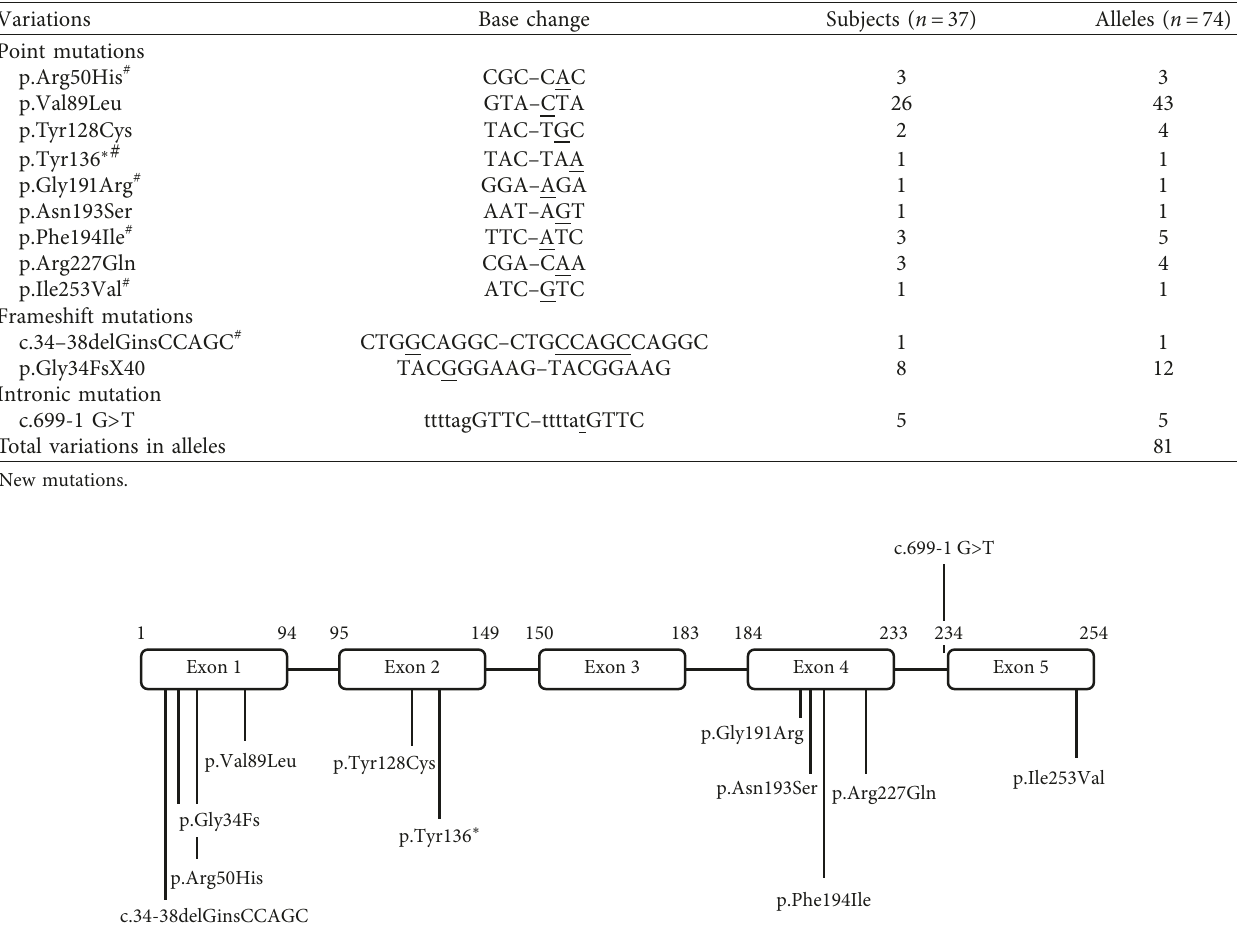
Table 1: Variations of the SRD5A2 genes detected in Indonesian cases of 5ARD2.